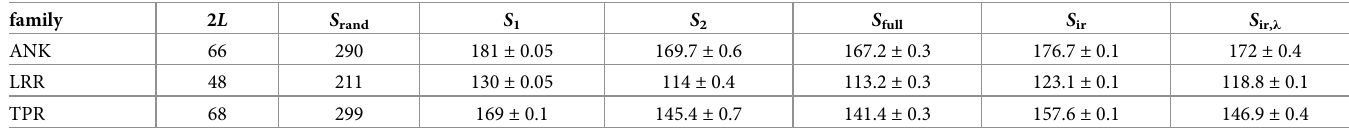
Table 1. Entropies (in bits, i.e. units of ln(2)) of sequences made of two consecutive repeats, for the three protein families shown in Fig 1. Entropies are calculated for models of different complexity: model of random amino acids ( S rand = 2 L ln(21), divided by ln(2) when expressed in bits); independent-site model ( S 1 ), pairwise interaction model ( S 2 ); pairwise interaction model with constraints due to repeat similarity λ ID ( S full ); pairwise interaction model of two non-interacting repeats learned without ( S ir ) and with ( S ir, λ ) constraints on repeat similarity. Fig 2 shows graphically some of the information contained in this